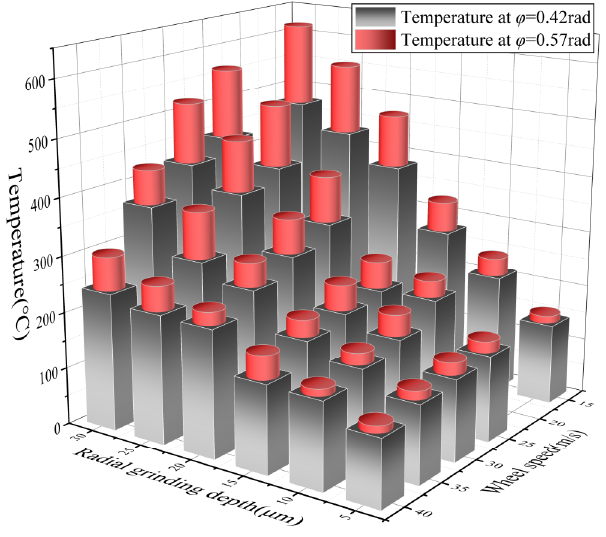
Figure 3. Grinding temperature of tooth.